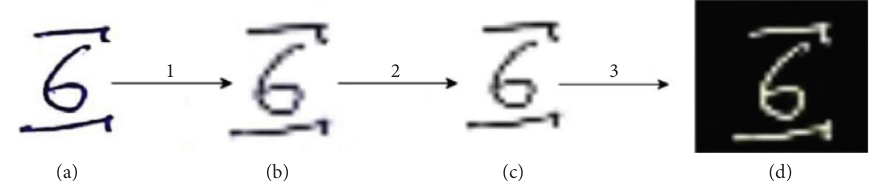
Figure 3: Geez handwritten digit image after some preprocessing techniques. (a) Original image (b) Resize image. (c) Grayscale image. (d) Black background image.